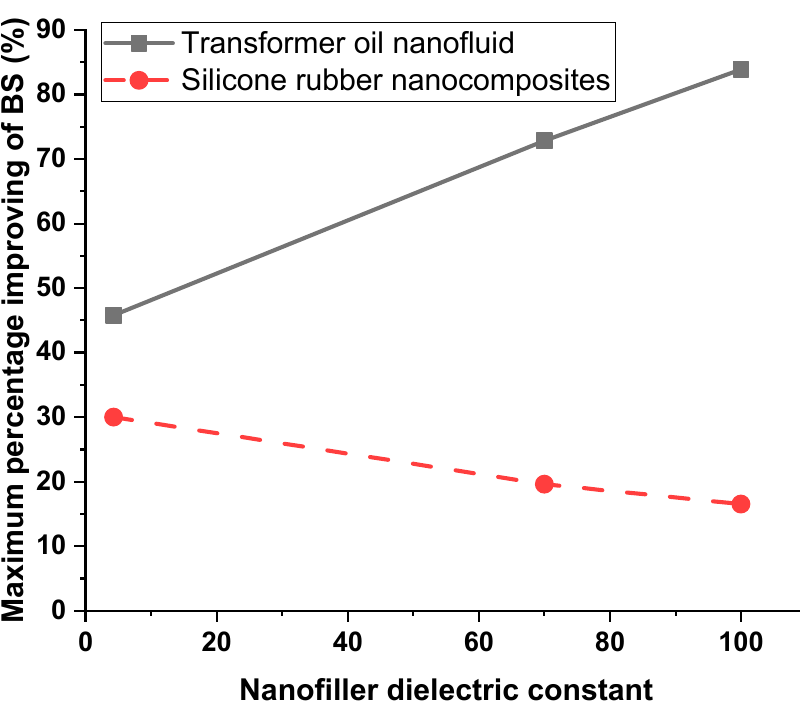
Figure 13. Maximum percentage improvement of average breakdown strength (BS) of transformer oil and silicone rubber. Table 1. Maximum breakdown strength and maximum percentage increase for transformer oil and silicone rubber.